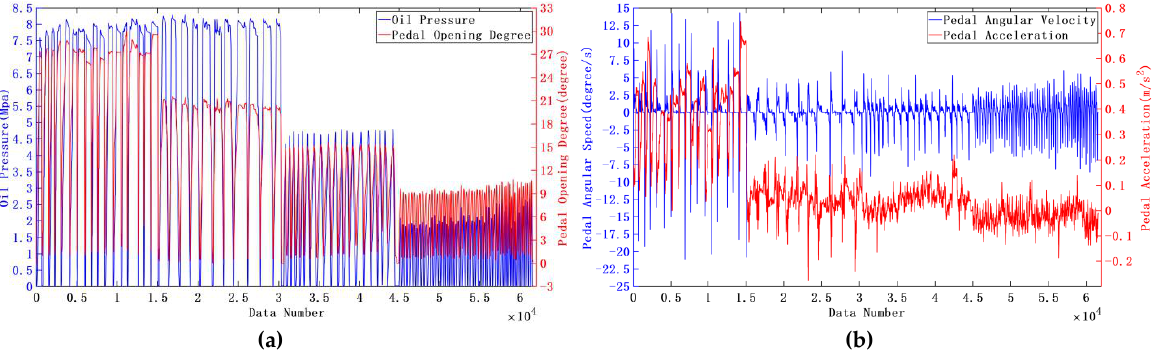
Figure 5. Sampled data under general braking conditions: ( a ) Sampled data of actual oil pressure and θ . ( b ) Sampled data of ω and α .